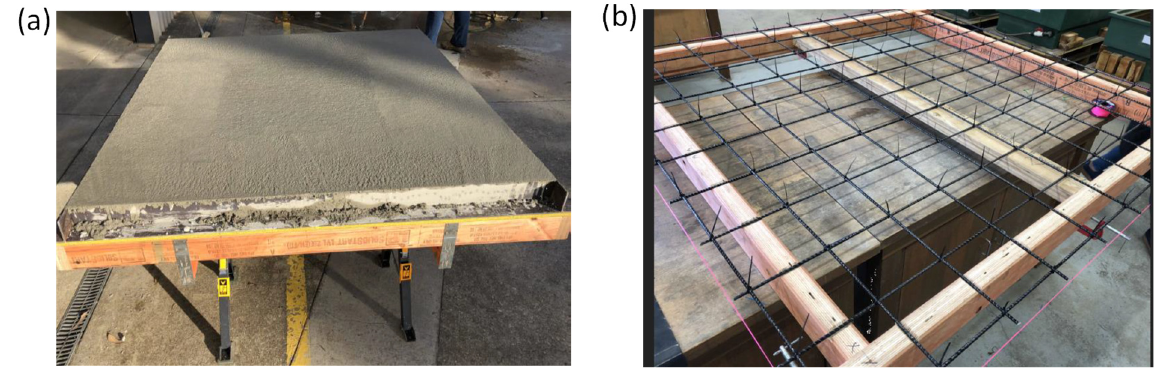
Figure 3. Photos of ( a ) a concrete slab after casting and ( b ) the single-layer reinforcement of a slab.